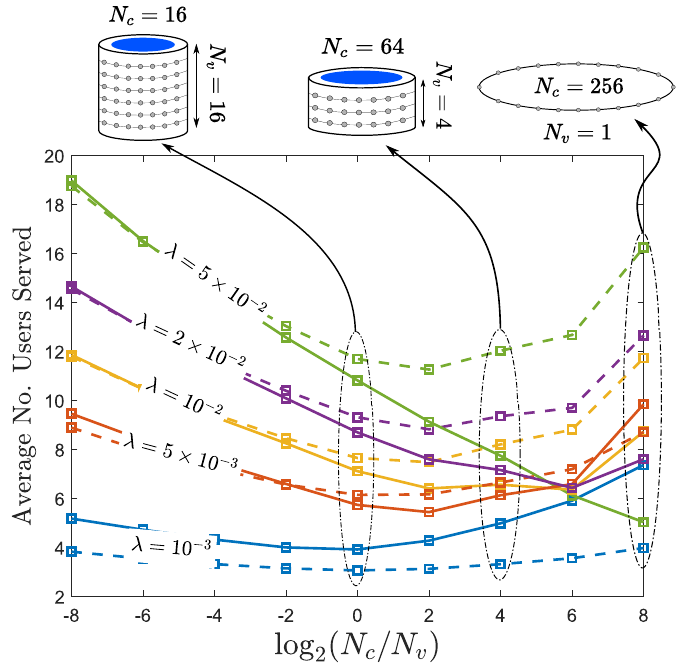
( N c / N v ) , within ¯ R = 100 m 2